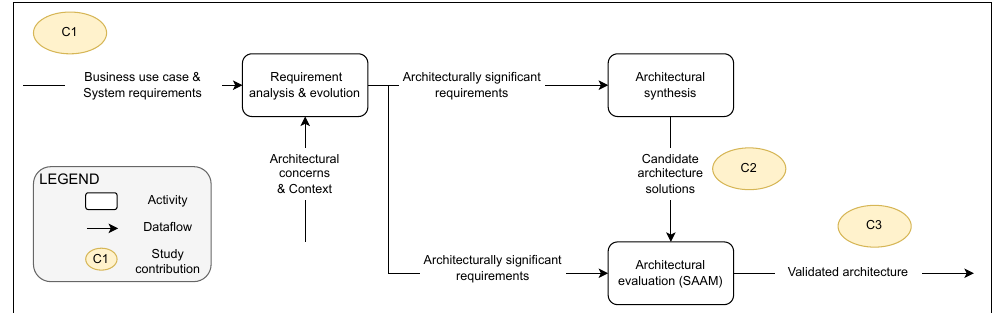
Figure 1. An overview of the research approach and contributions using Hofmeister et al.’s [28] approach for architecture